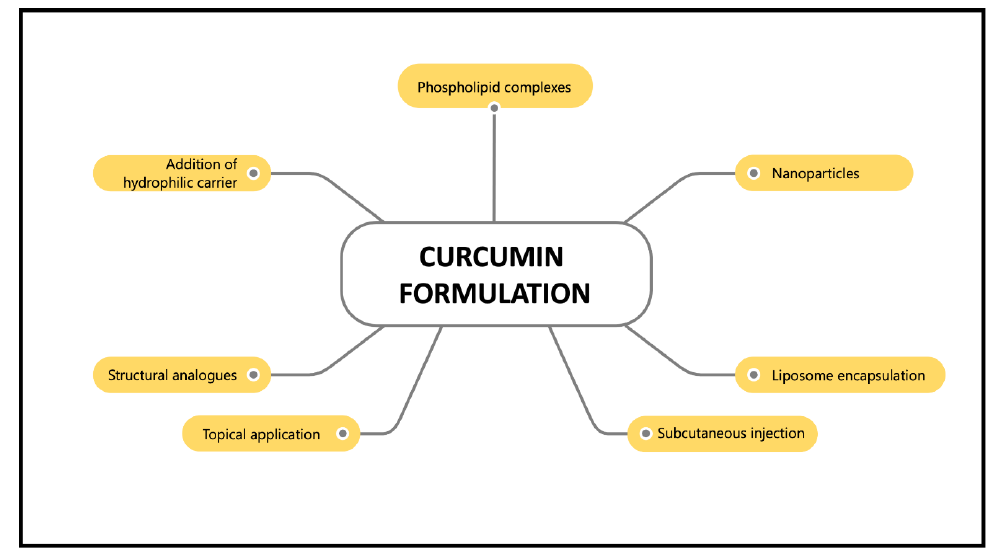
Figure 3. Various curcumin formulations that enhance its bioavailability.